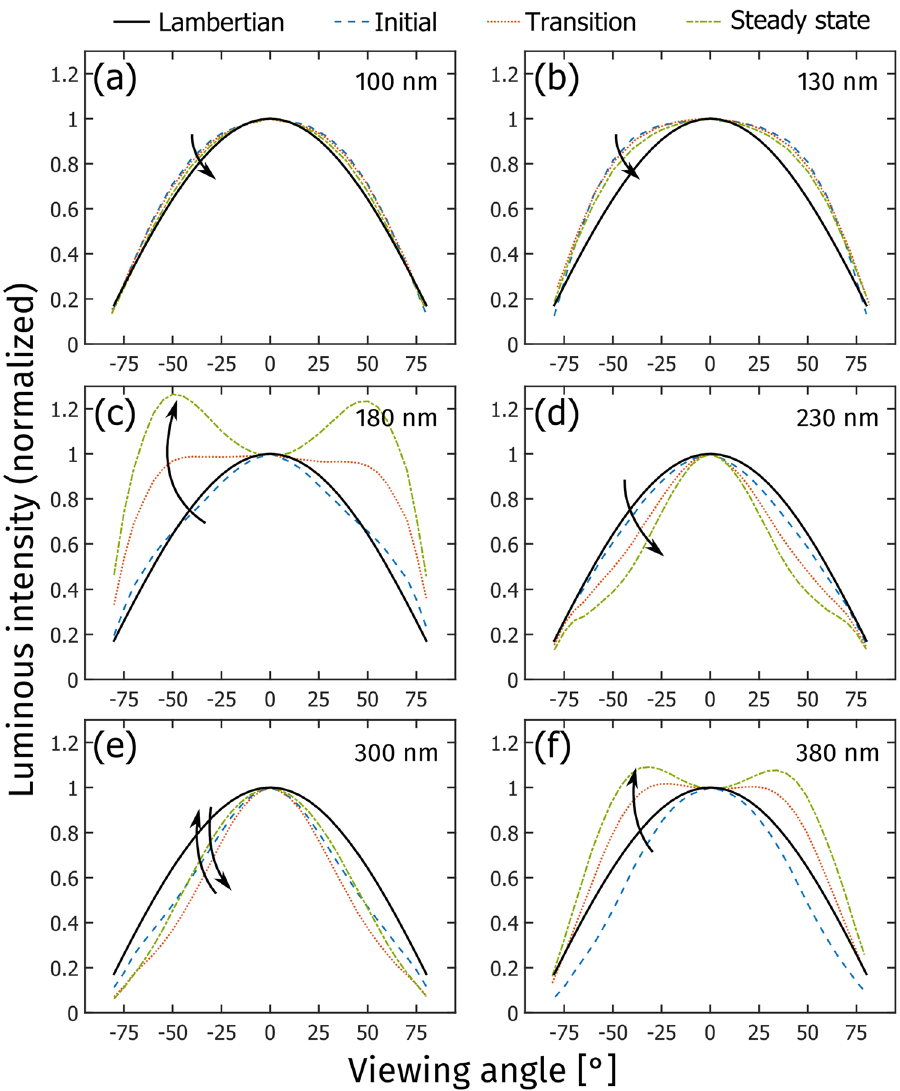
Figure 3. ( a ) The temporal evolution of the luminous efficacy for LECs with different active-layer thickness: 100 nm (solid blue squares), 130 nm (open red diamonds), 180 nm (yellow stars), 230 nm (open purple circles), 300 nm (solid green triangles), and 380 nm (open light-blue stars). ( b ) The steady-state luminous efficacy (solid purple pentagons) and the steady-state forward luminance (yellow crosses) as a function of the active-layer thickness. ( c ) The steady-state Lambertian correction factor (K L ) as a function of active-layer thickness. The grey dotted line (K L = 1) is the result of a Lambertian emitter. ( d ) The steady-state emission peak wavelength in the forward direction (solid squares), and at a viewing angle of 70° (open circles), as a function of the active- layer thickness. ( e ) The simulated K L as a function of active-layer thickness. ( f ) The simulated emission peak wavelength in the forward direction (solid blue squares), and at a viewing angle of 70° (open red circles), as a function of the active-layer